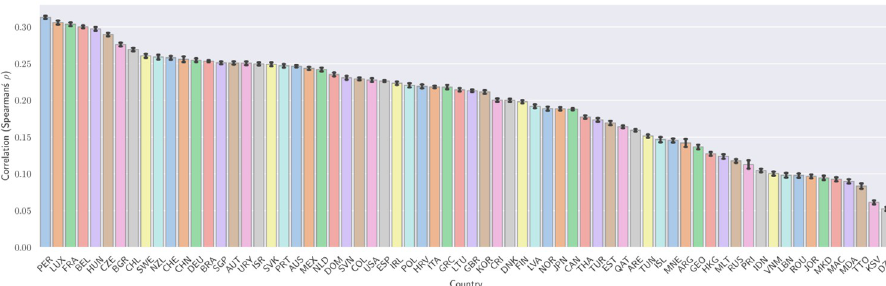
Fig 2. The correlation (Spearman’s ρ ) between student points in mathematics and science, and student ESCS for the participating countries (ISO 3166-1 alpha-3 codes). The error bars indicate a 95% confidence interval obtained by bootstrapping the data using the student weights (details in Methods). It is evident that privileged students (high ESCS) tend to perform better in PISA in many countries, but this tendency is weaker in countries to the right in the